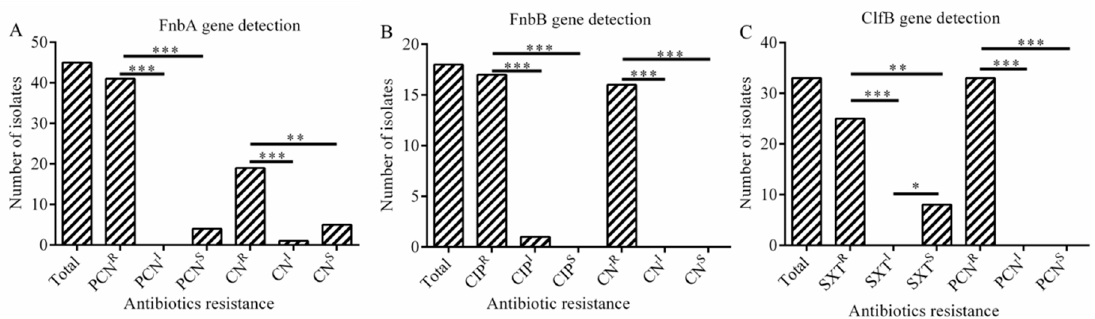
Figure 4. The relationship between adhesion as well as biofilm-related genes and antibiotic resistance ( A – C ). ( A ) Correlation between fnbA gene and antibiotic resistance. ( B ) Correlation between fnbB gene and antibiotic resistance; ( C ) Correlation between clfB gene and antibiotic resistance. Statistics were achieved by independent sample test and ANOVA (*** p < 0.001, ** p < 0.01, * p < 0.05). PCN R : resistance